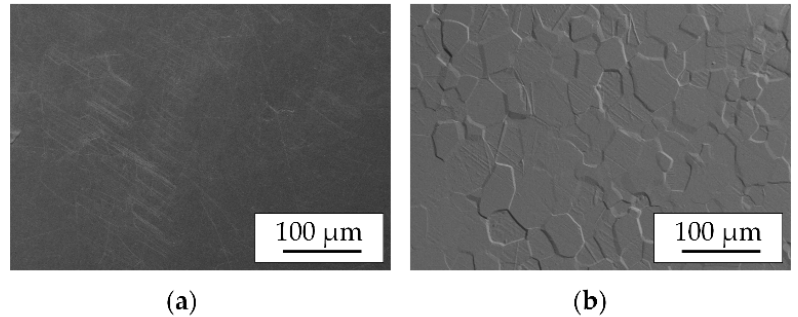
Figure 1. Surface topography ( a ) and microstructure ( b ) of titanium Grade 2 in the initial state. Table 1. Chemical composition and mechanical properties of titanium Grade 2 (according to ISO 5832-2).